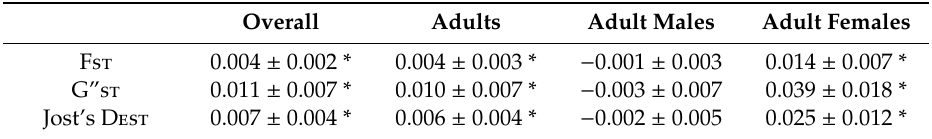
Table 3. Overall and sex-specific estimates and standard deviations of genetic di ff erentiation between the APNR and KNP elephants. Asterisks indicate significant values at α =